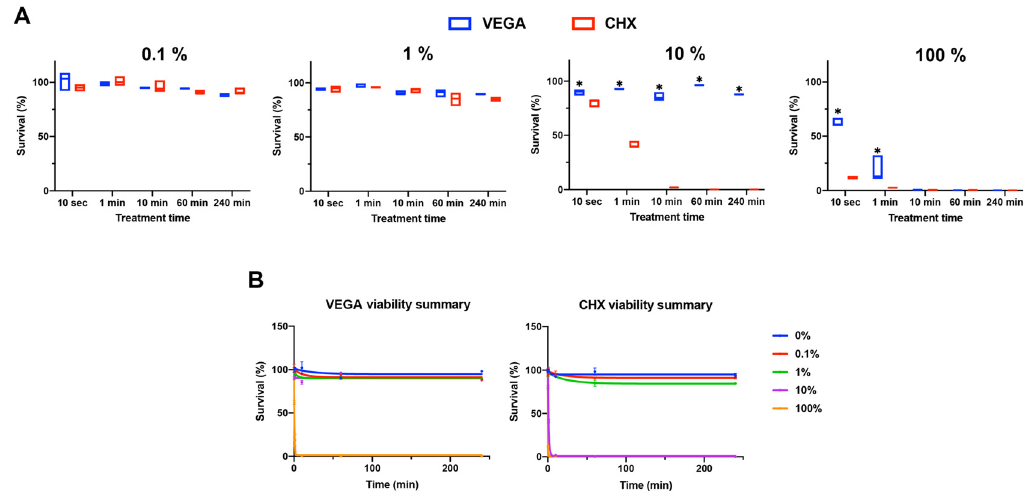
Figure 2. Cell viability of HGF-1 cells exposed to 0.1%, 1%, 10%, or 100% of antiseptic oral rinses (either VEGA or CHX) for 10 sec, 1 min, 10 min, 60 min, and 240 min. ( A ) Two antiseptic oral rinses at each dilution were compared for cell survival properties. (n = 3, * denotes significantly higher than the other treatment modality, p < 0.05). ( B ) The effect of dilutions of antiseptic oral rinses on cell survival was summarized. In general, 0.1% and 1% antiseptic oral rinses did not affect cell viability.